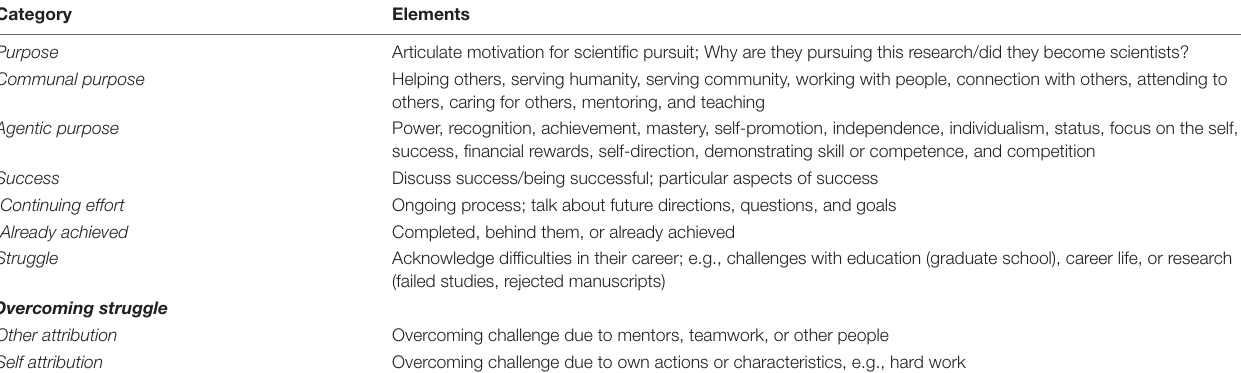
TABLE 1 | Coding categories and